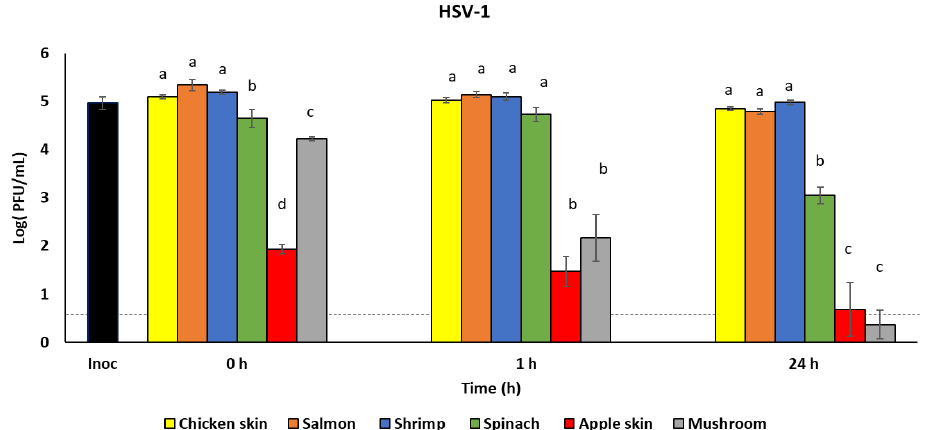
Figure 2. Survival of HSV-1 on foods. HSV-1 was recovered from foods immediately after inoculation (0 h) and at 1 h and 24 h after incubation at 4 ◦ C ( n = 3). Infectious virus titer was quantified by plaque assay on Vero 76 cells and shown as log PFU/mL. Inoculum (Inoc) is shown as PFU/sample. Dashed line indicates detection limit of the plaque assay (0.7 log pfu/mL). a–d Means within an incubation time that have a common lowercase letter are not significantly different ( p < 0.05).